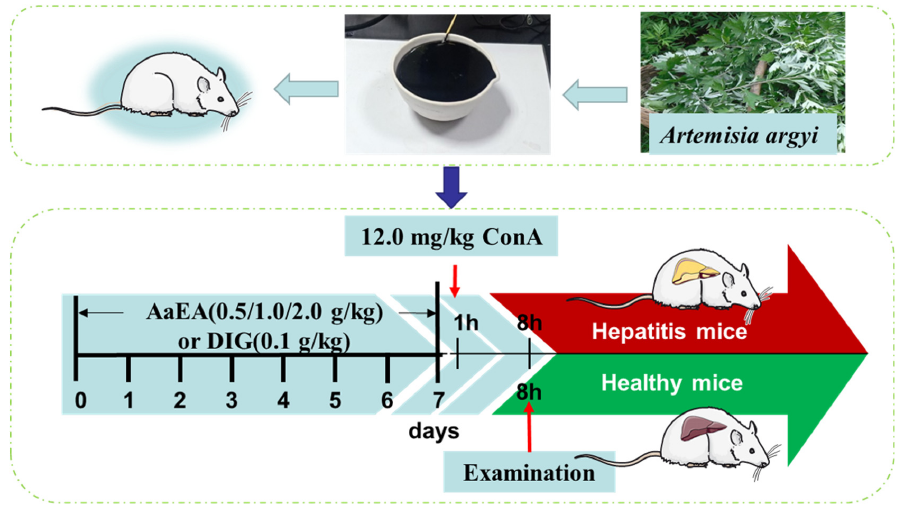
Figure 11. The process is designed for animal